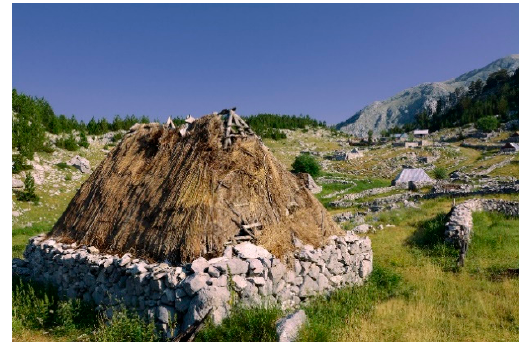
Figure 28. Roof cover of straw – Radan, photo: I. Lakovi ć .